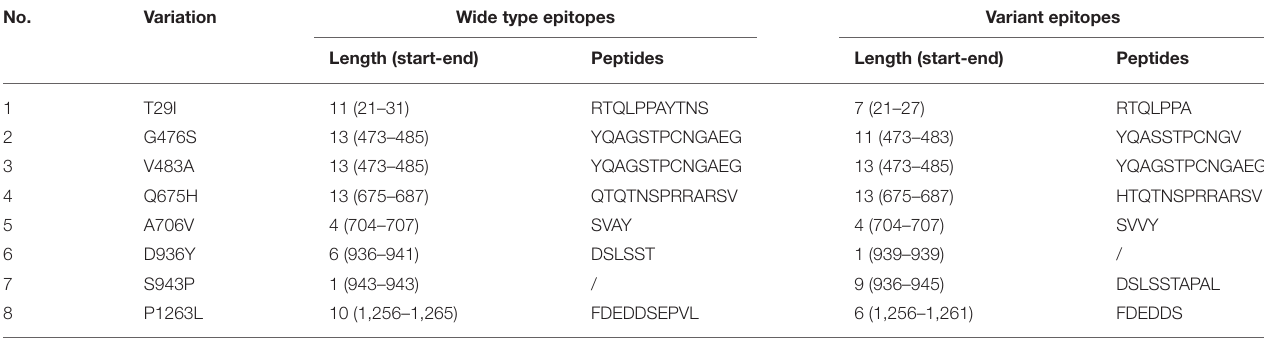
TABLE 1 | Variations in linear B cell epitope prediction of SARS-CoV-2 spike protein and its impacts. No.